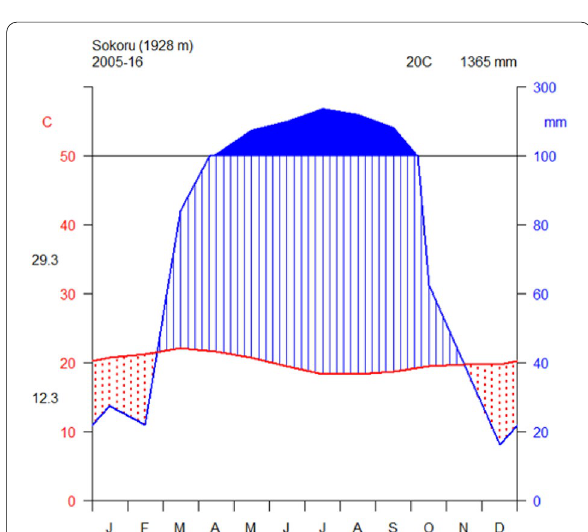
Fig. 3 Climate diagram showing the mean monthly rainfall and temperature distribution records of Saja Laften taking 10 years (2007–2016) (Source: Unpublished Ethiopian National Meteorological Services Agency